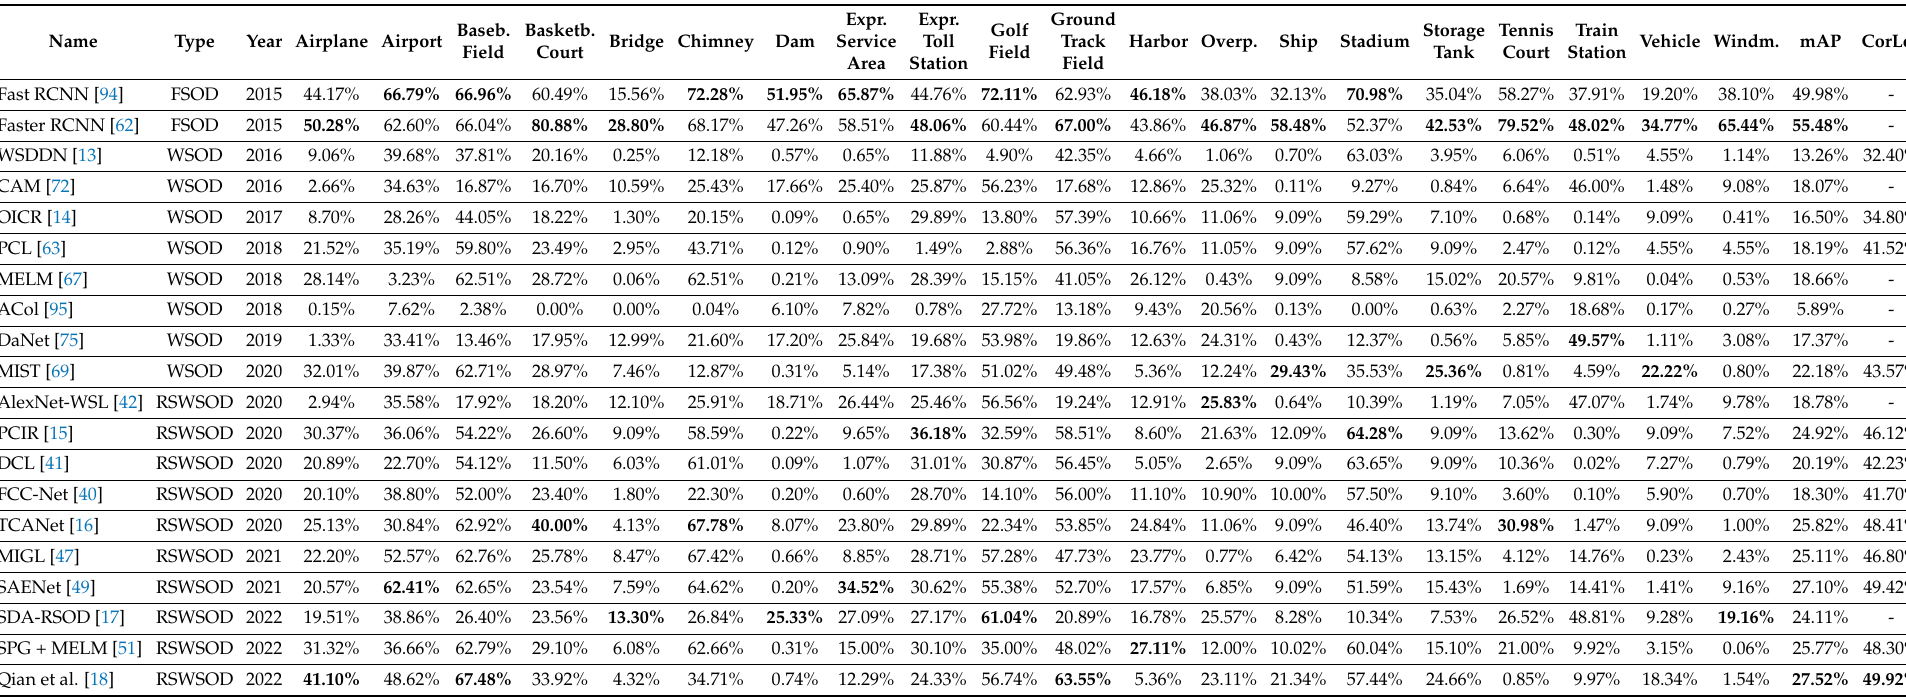
Table 5. Results of the methods on the DIOR dataset. Two well-known fully supervised methods from the literature are reported for a fair comparison. The columns report the Average Precision (AP) for each category, the mean Average Precision (mAP), and the CorLoc for each method. The best-performing techniques for each class are indicated in